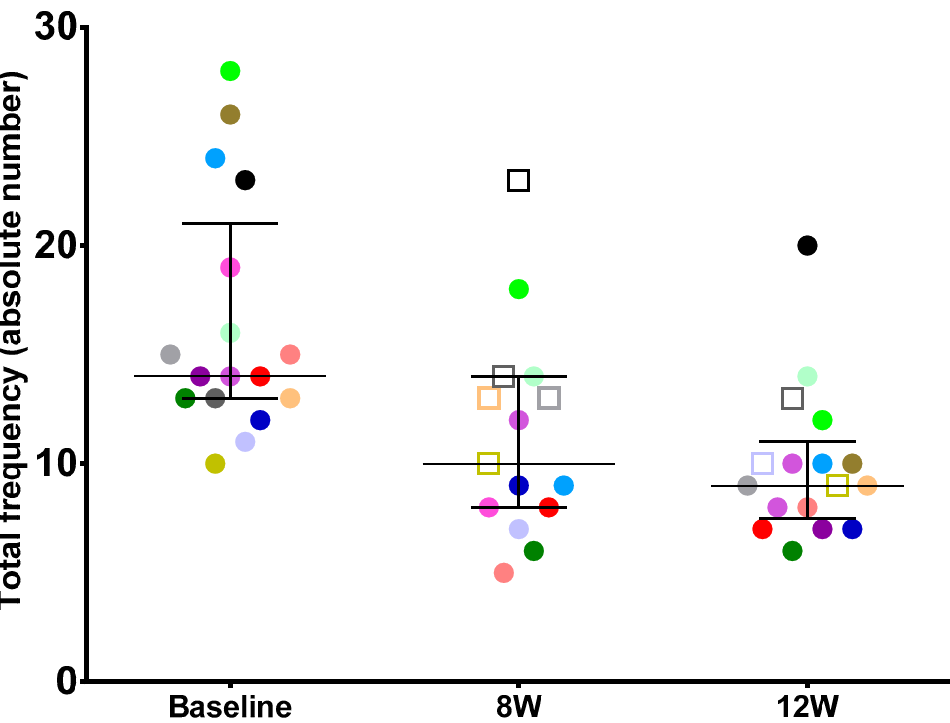
Figure 2. Median and (p25–p75) intervals and individual total daily frequency at baseline and weeks 8 and 12. Each patient is identified by a specific color, and, when represented as a square at 8w or 12w, this means that MID was not reached.